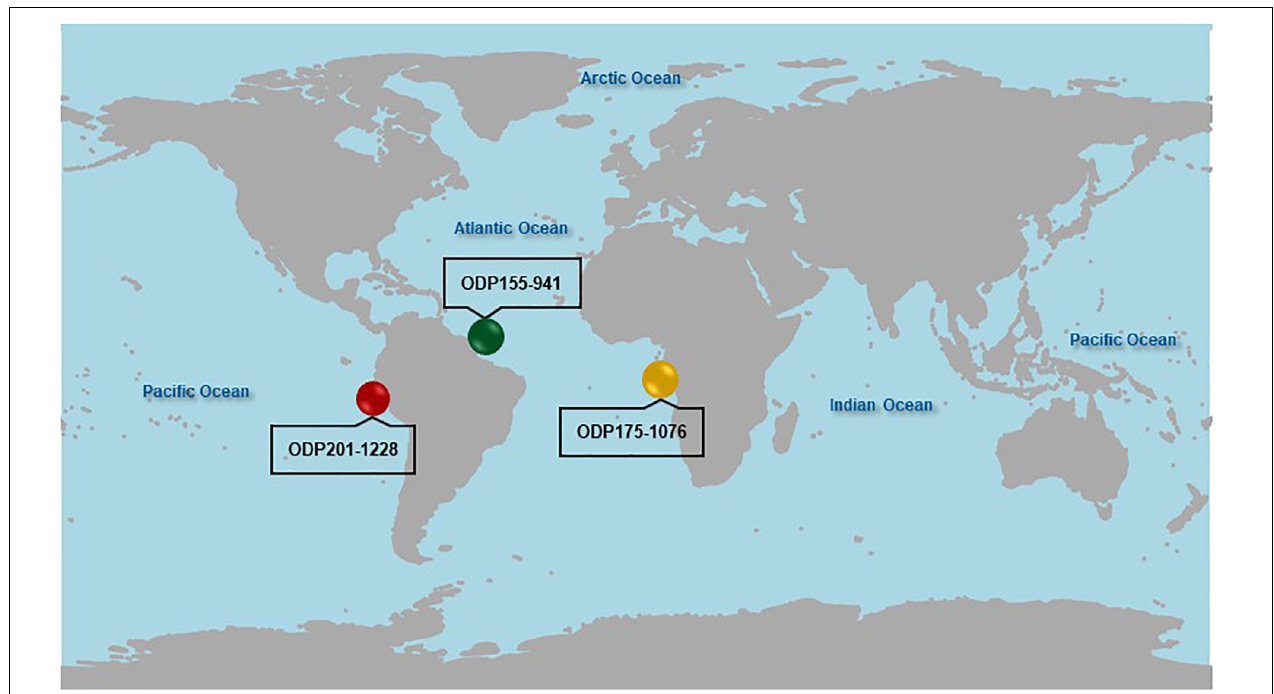
FIGURE 1 | Locations of the ODP175-1076 core in the Congo Basin, ODP201-1228 core in the Peru Margin, and ODP155-941 core in the Amazon